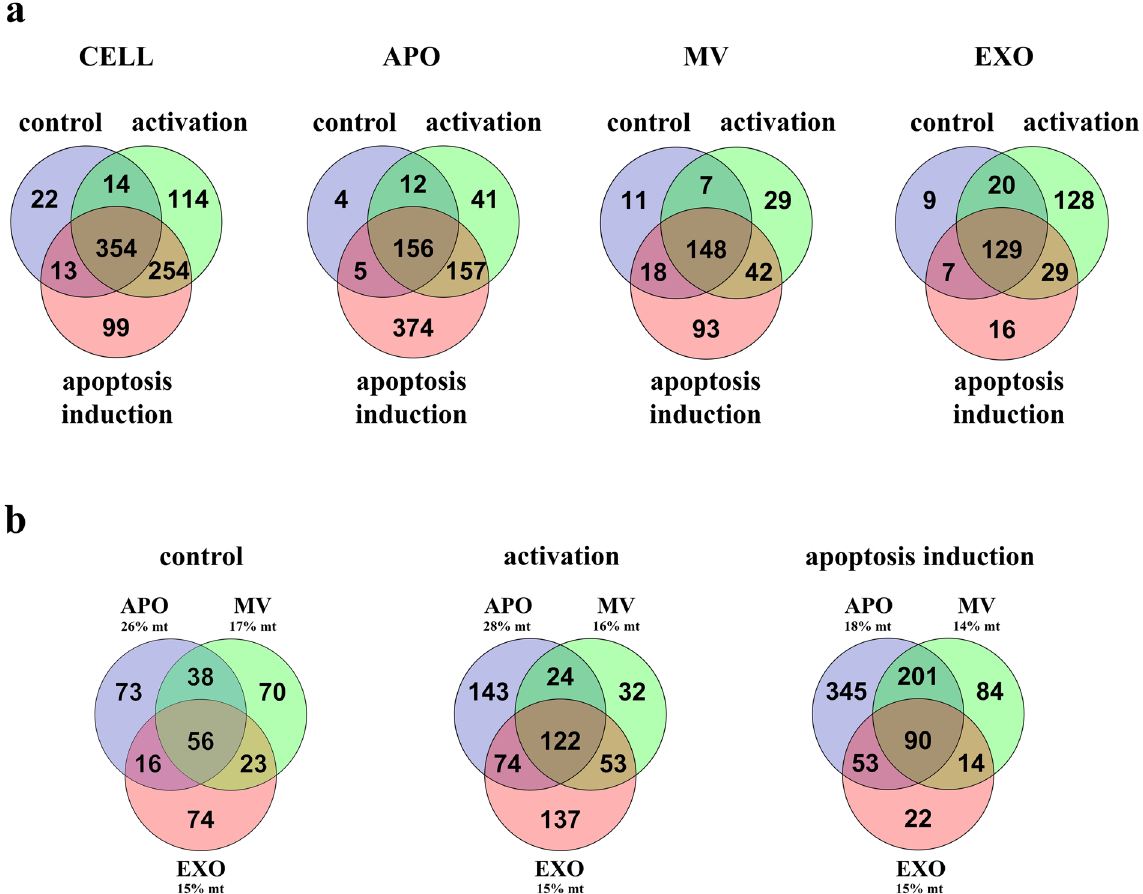
Figure 8. Mass spectrometry analysis of extracellular vesicles (EVs). (a) Venn-diagrams of ciprofloxacin- exposed control, activated and apoptotic Jurkat cells and released APOs, MVs and EXOs. (b) Venn-diagrams of EVs derived from ciprofloxacin-exposed control, activated and apoptotic Jurkat cells. Percentages of mitochondrial proteins exclusively specific for apoptotic bodies (APOs), microvesicles (MVs) or exosomes (EXOs) are indicated in the graphs, respectively. mt: mitochondrial